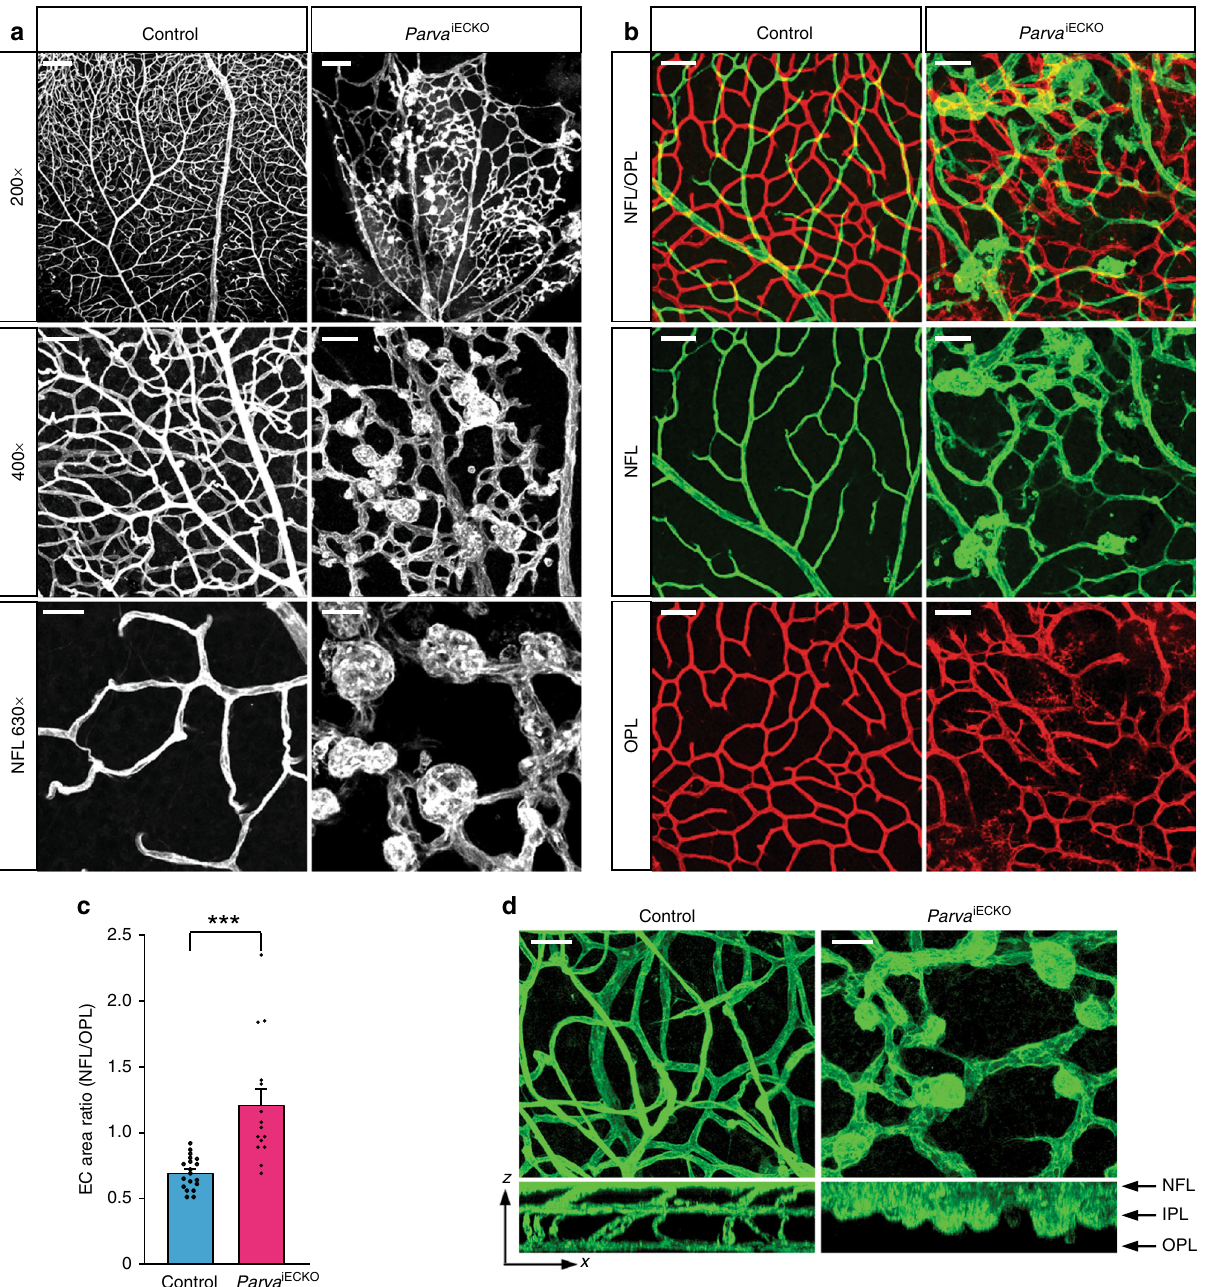
Fig. 4 EC-speci fi c knockout of Parva phenocopies Ilk iECKO vascular defects. a Confocal images of isolectin B4 stained P16 control and Parva iECKO retinas. Note large and blind-ended EC bulges in the Parva iECKO but not the control vasculature. Scale bar, 150 μ m (top), 50 μ m (center), and 25 µ m (bottom). b , c Images of isolectin B4-stained retinal vessels with pseudo-coloring of the NFL (green) and OPL (red) vasculature ( b ). Parva iECKO EC bulges are con fi ned to the NFL, whereas the mutant OPL vessel density is decreased resulting in a signi fi cant increase of the NFL/OPL EC area ratio ( c ). Scale bar, 50 μ m in ( b ). Error bars, s. e.m. p values (*** p < 0.001), Student ’ s t test ( n = 5 control and 4 mutant retinas). d XZ projection images of isolectin B4-stained control and Parva iECKO retinas. Mutant NFL vessels are enlarged and vertical sprouting is impaired. Scale bar, 25 μ m. Source data are provided as a Source Data fi